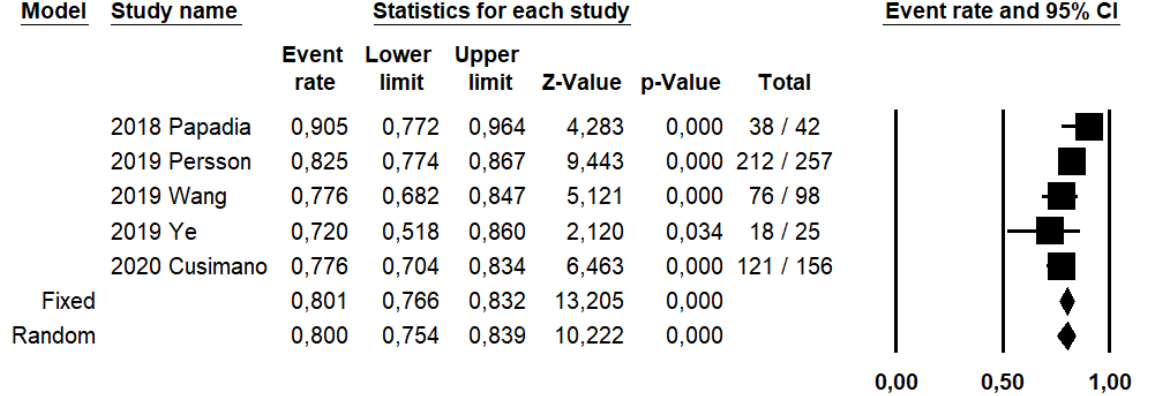
Figure 5. Forest plots of individual studies and pooled bilateral detection rate of sentinel lymph